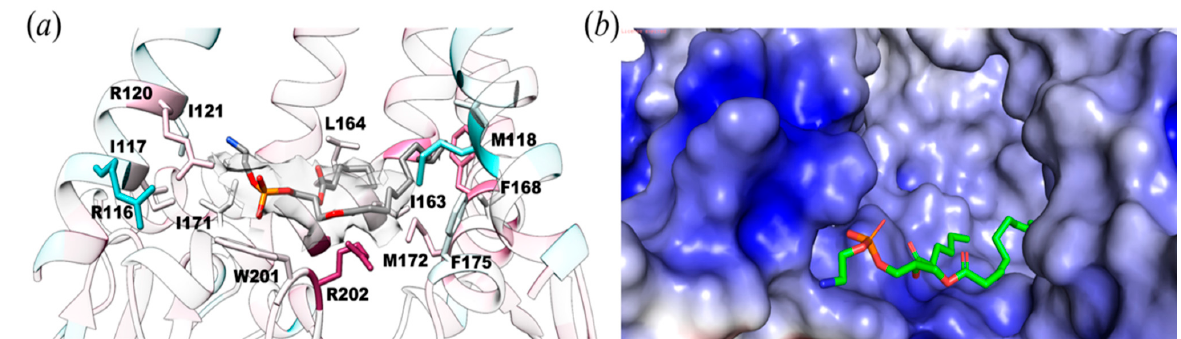
Figure 3. Protein-lipid interactions within 6 Å of YnaI. ( a ) Potential lipid molecule (density shown as transparent surface) interacts with R116, R120, I163, F167, M172, F175, W201, and R202. ( b ) Same orientation as in A but shown as the electrostatic surface of the binding pocket of lipid within YnaI that interacts with a lipid molecule. Electrostatic surface potentials were calculated using PyMol and APBS [38] with the non-linear Poisson–Boltzmann equation. Negatively and positively charged surface areas are colored in red and blue, respectively.